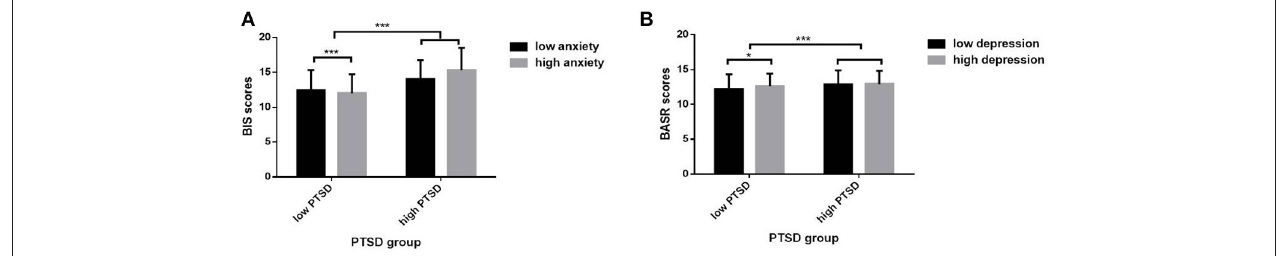
FIGURE 1 | Interaction effects of mood symptoms on BIS/BAS sensitivities. (A) The interaction effect between PTSD and anxiety on BIS level. (B) The interaction effect between PTSD and depression on BASR level. * P < 0.05, *** P < 0.001.